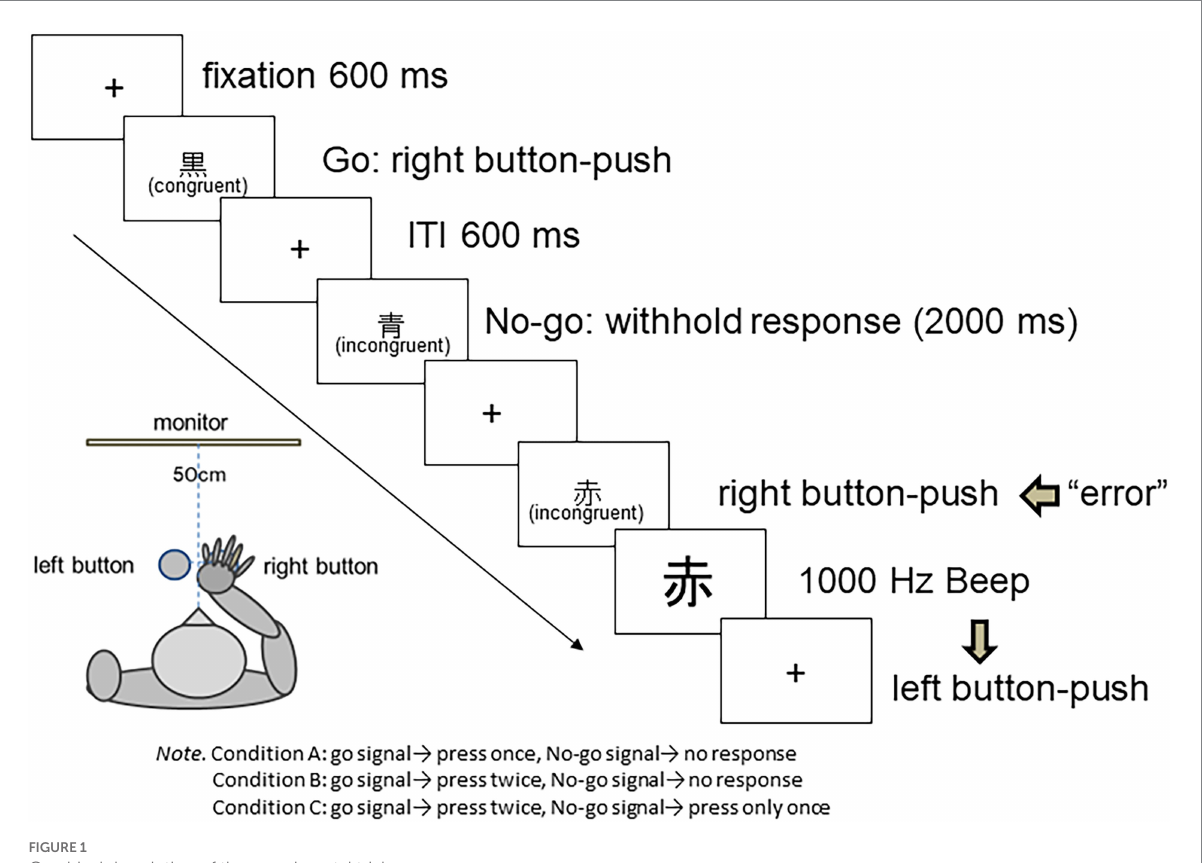
FIGURE 1 Graphical description of the experimental